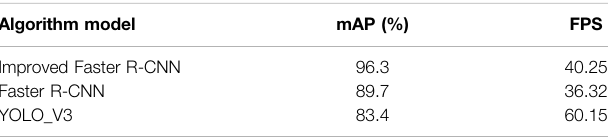
TABLE7| ComparativeanalysisofimprovedfasterR-CNNonthedetectionresult of logical elements. Algorithm model